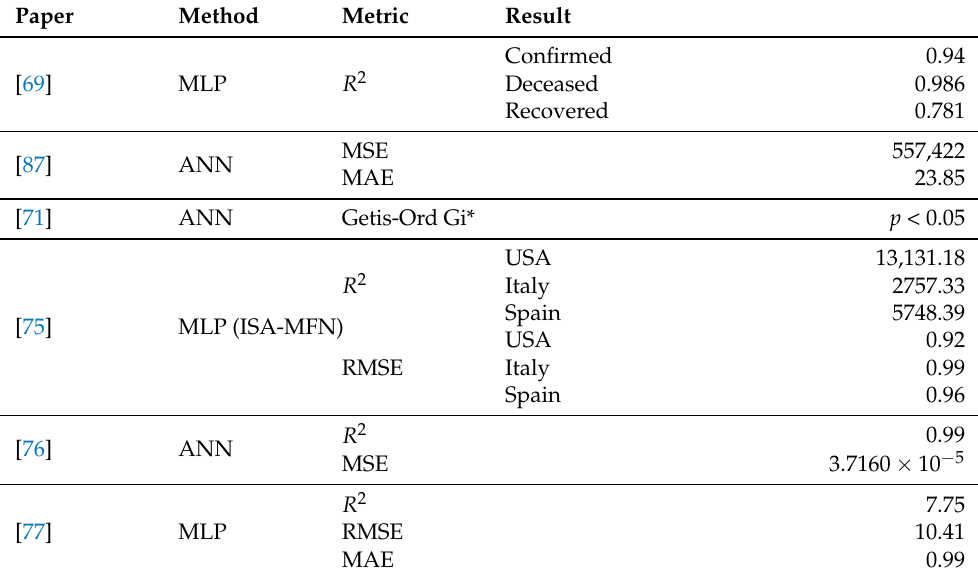
Table 5. Result comparison for feed-forward ANN-based